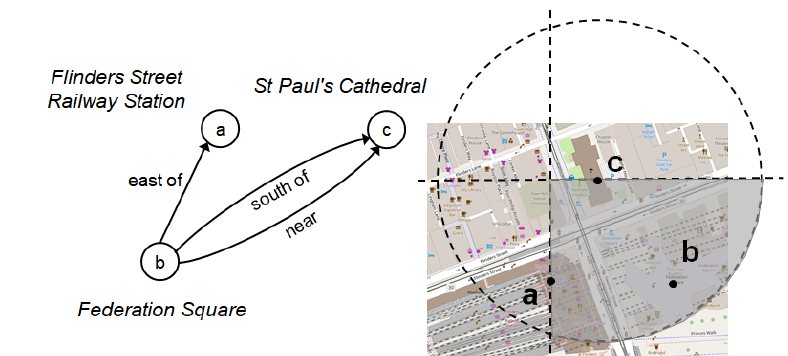
Figure 7. An example of deriving the ALR for place b through intersection of search